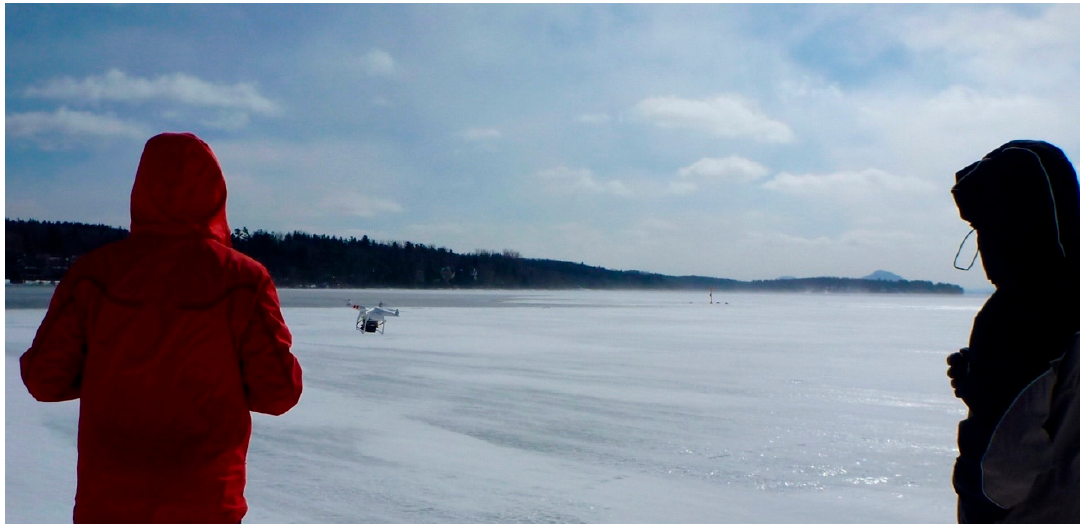
Figure 9. The remotely piloted aircraft in flight. A buoy can be seen in the background where open water starts (ice thickness = 0 cm, stream flow channel in the frozen lake).